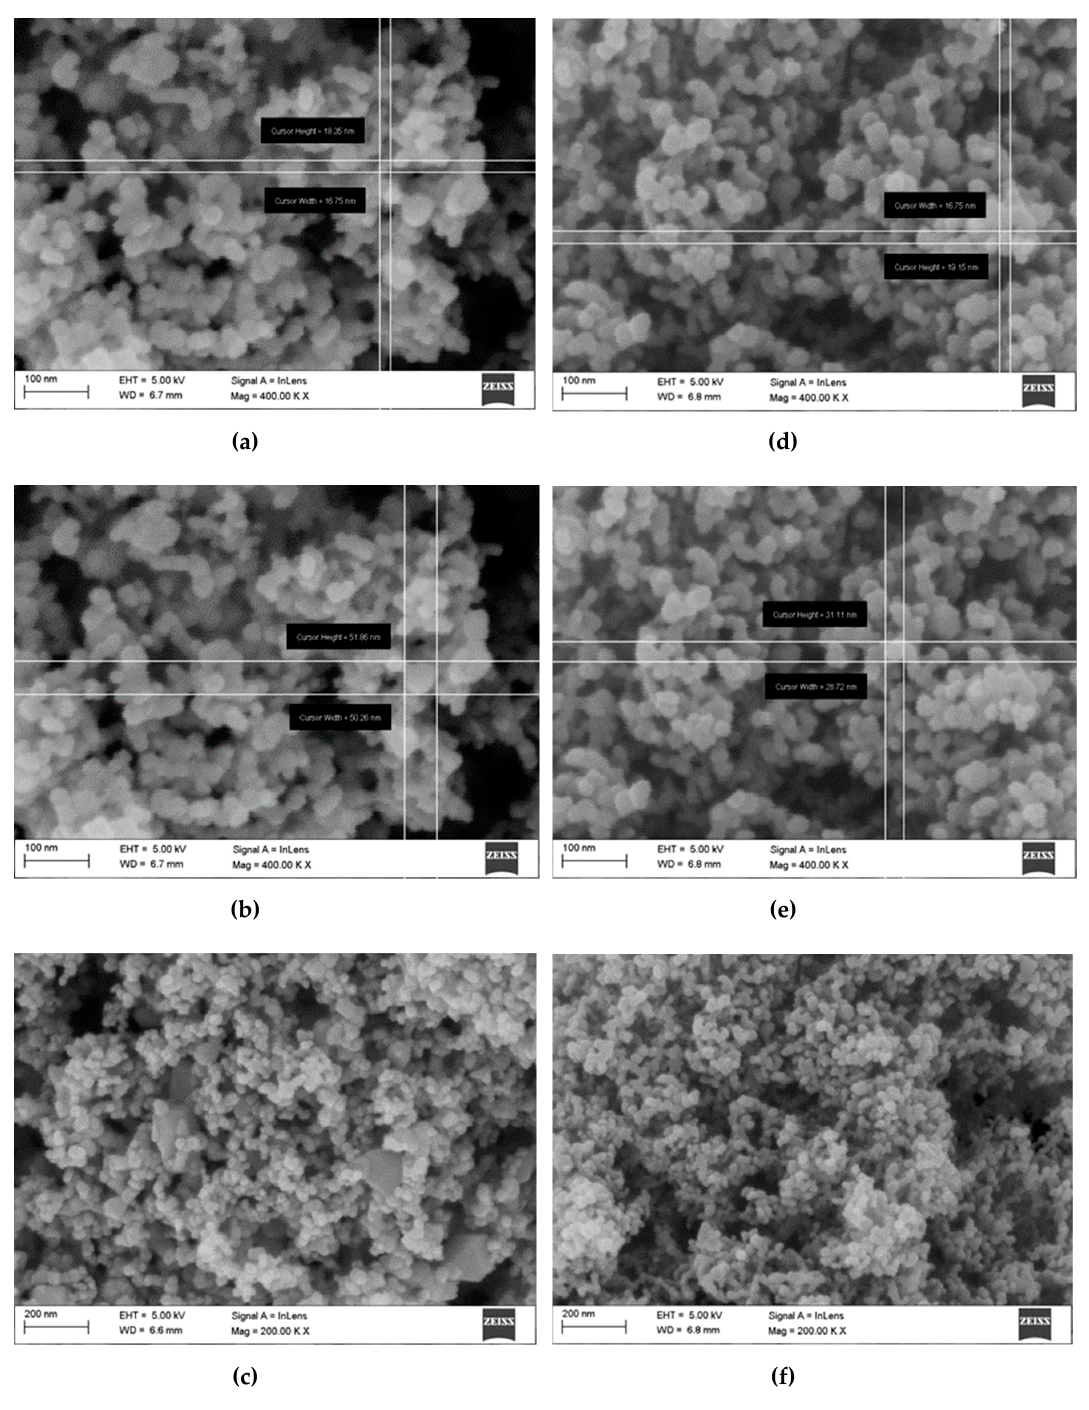
Figure 1. SEM photos of titanium nano dioxides, ( a ), ( b ) P25 (400×), ( d ), ( e ) P90 (400×), ( c ) P25 (200×), ( f ) P90 (200×). ( f ) P90 (200 ×